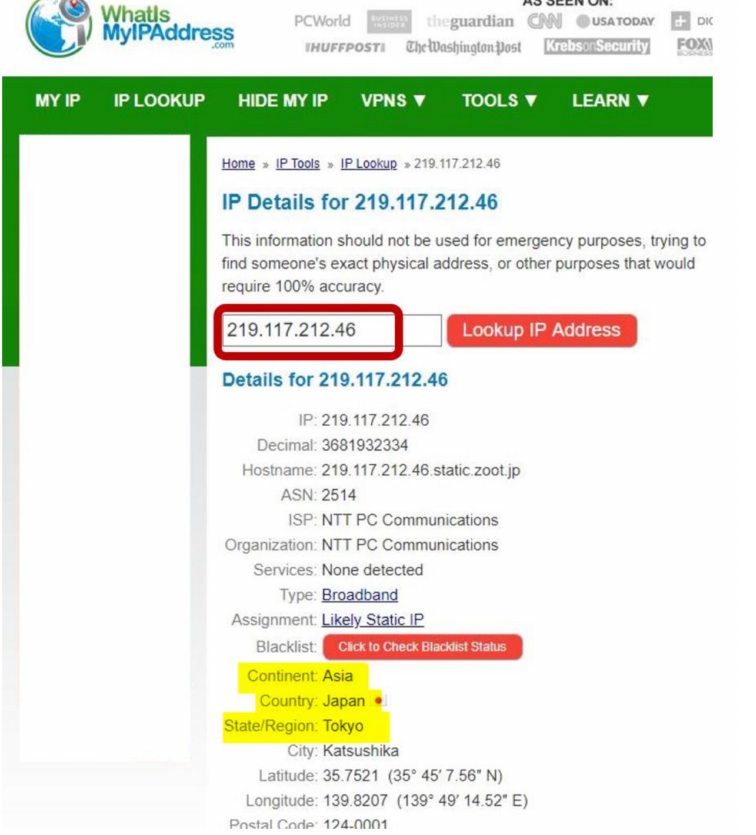
Figure 3. Example of checking the IP location on WhatIsMyIPAddress website, in which the continent of the IP address was